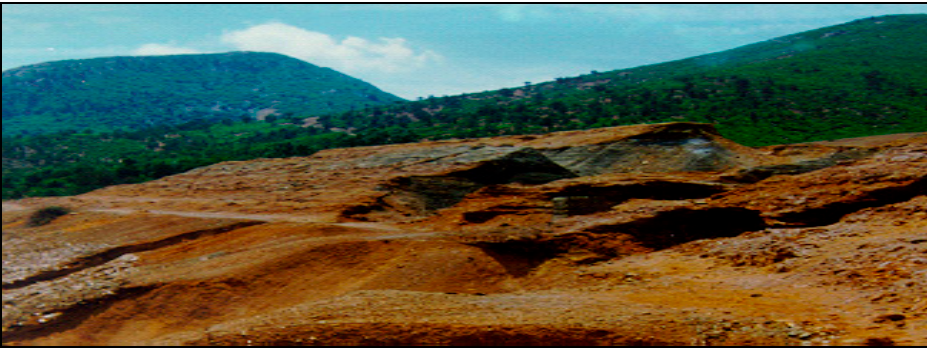
Figure 1. Tailings of a mining site in Romania.